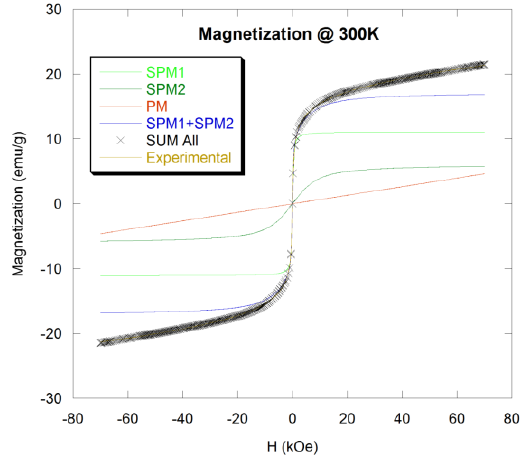
Figure 8. Magnetization curves for Gd-substituted MnZn-ferrite nanoparticles where saturation is not achieved even at very large applied field. Two superparamagnetic and one paramagnetic component are required for good fitting. These extra components can be explained in terms of isolated spins or dead phases (see